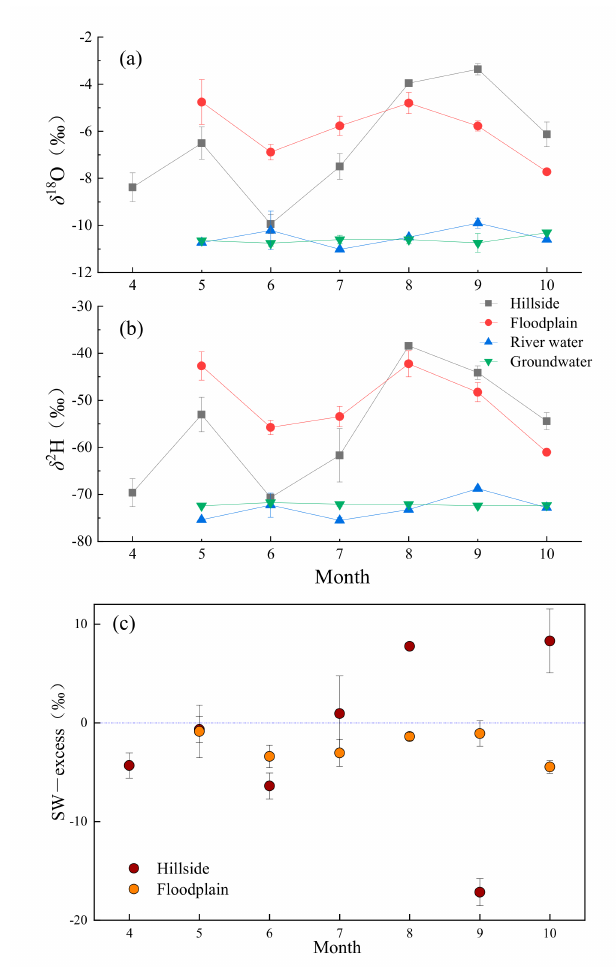
Figure 6. Temporal variations of δ 18 O ( a ) and δ 2 H ( b ) xylem water, groundwater and Yellow river water in the hillside and floodplain habitats and SW-excess ( c ) of T. ramosissima during the sampling periods (Mean ± SD, N =